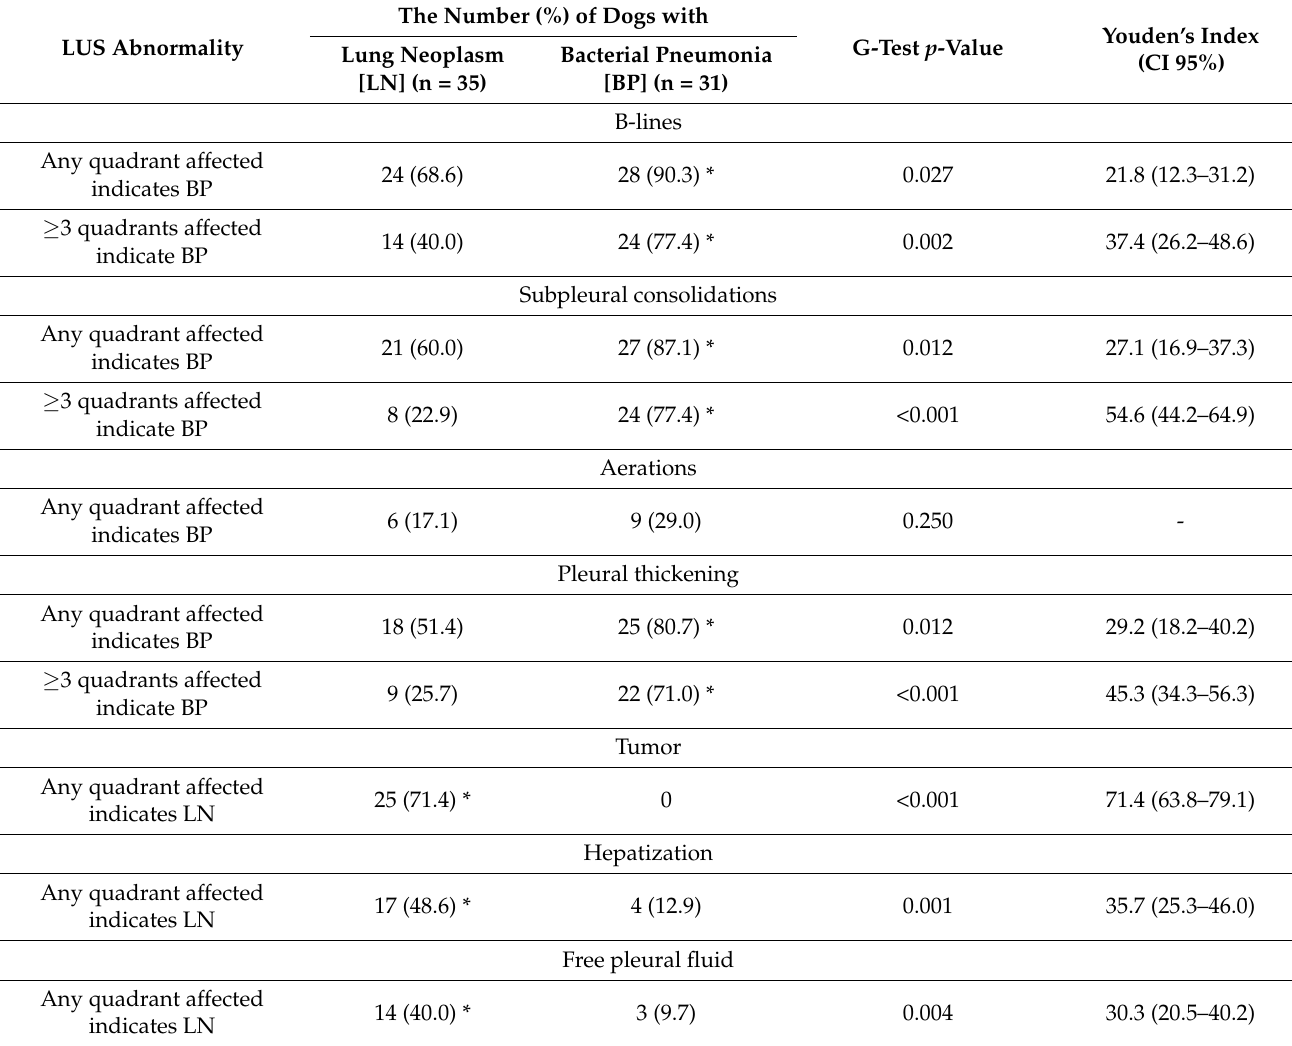
Table 2. Comparison between the definitive diagnosis and lung ultrasound (LUS)